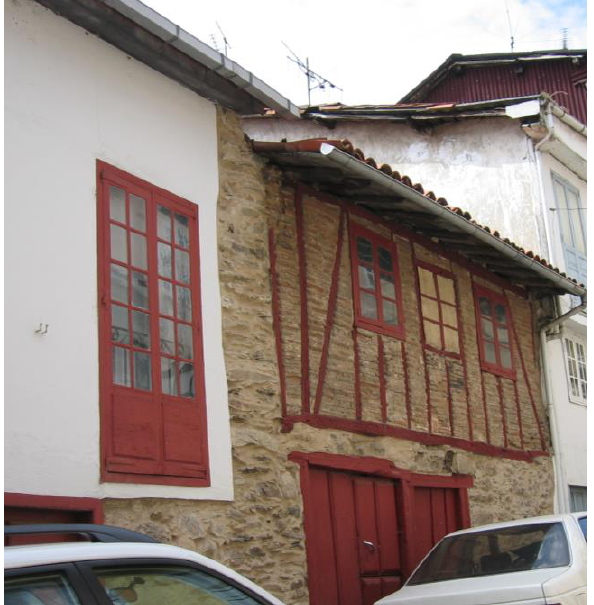
Figure 5. Houses of medieval origin with half-timbered walls with brick filling in Monforte de Lemos. The house on the left modified the facade openings at some later time. Source: A.F.P.